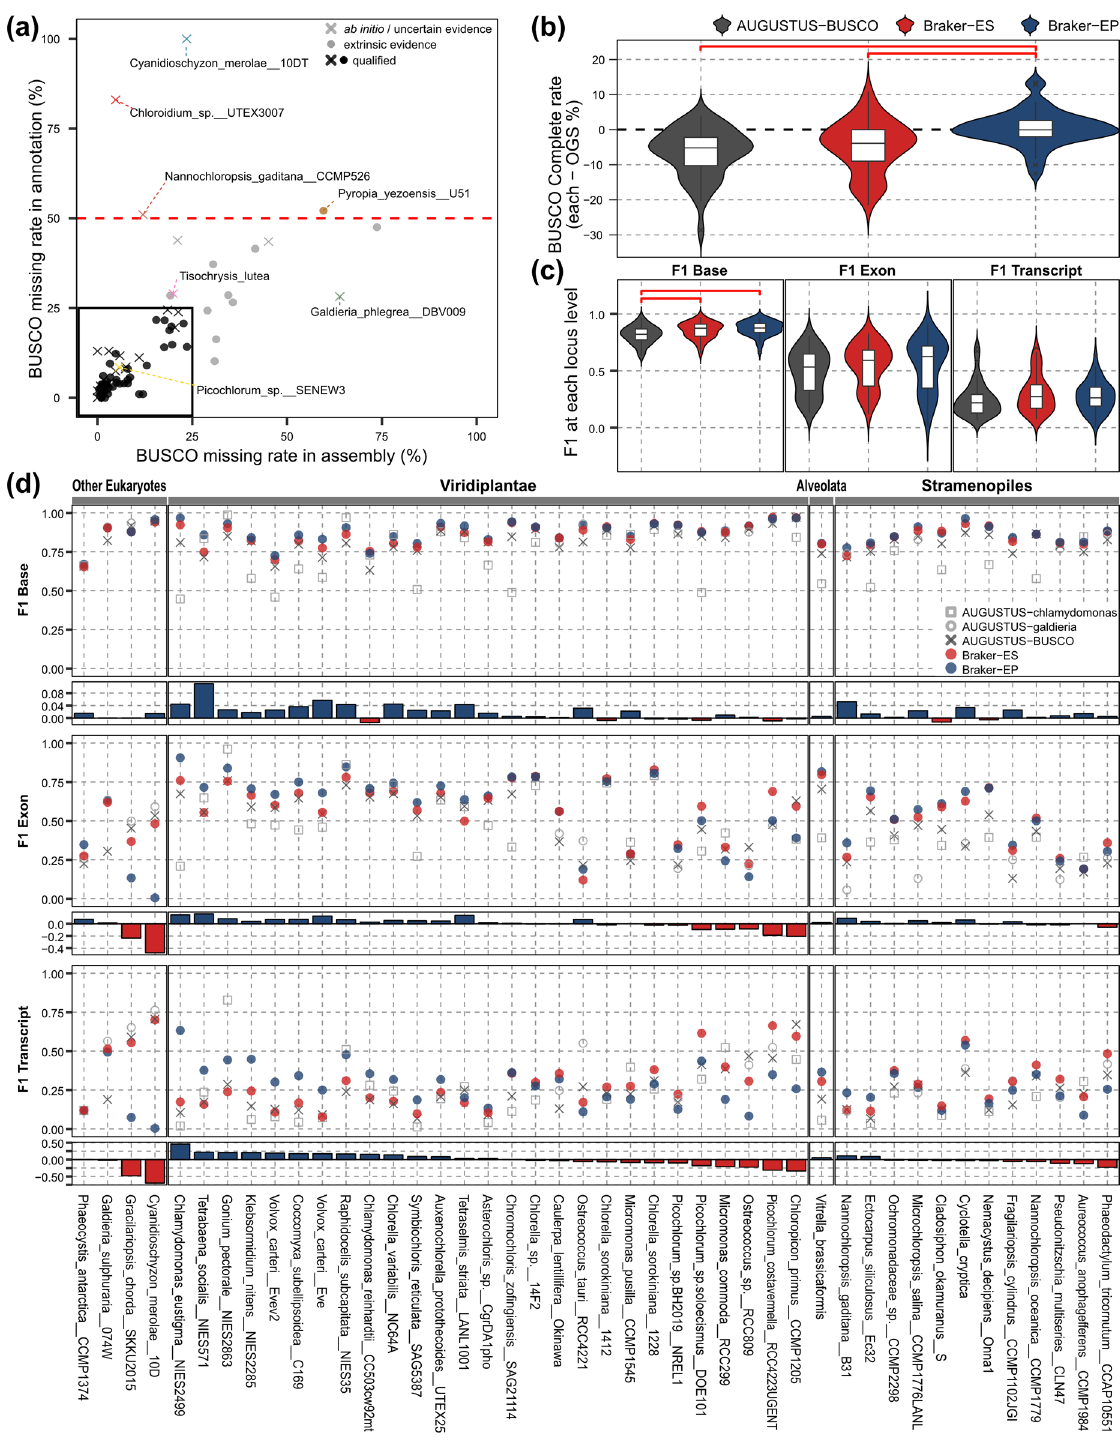
Figure 3. Evaluation of different gene prediction methods. ( a ) Missing rates from the BUSCO genome assessment (x-axis) and protein assessment (y-axis) in 83 annotated genomes. Genomes located in the black rectangle are considered high-quality official gene sets. High-quality official gene sets annotated using extrinsic evidence were marked as “qualified” official gene sets that are further used for the evaluation. Genomes indicated with their identifiers are re-annotated, of which details are summarized in Annotation assessment of Supplementary Table S1. ( b ) BUSCO complete rate comparison between the official gene set and three newly predicted gene sets. Positive values indicate that the newly predicted gene set outperformed the official gene set. Red brackets indicate significant difference (Wilcoxon rank-sum test p -value < 0.05). ( c ) F1 score comparison at all loci levels between three newly predicted gene sets. Red brackets indicate significant difference (Wilcoxon rank-sum test p -value < 0.05). ( d ) F1 scores of predicted gene sets at all loci levels. Only the best performing AUGUSTUS-default gene models are displayed. Bar graphs at the bottom of each F1 score plot display differences in F1 between Braker-EP and Braker-ES. Positive values indicate that Braker-EP gene model outperforms Braker-ES gene